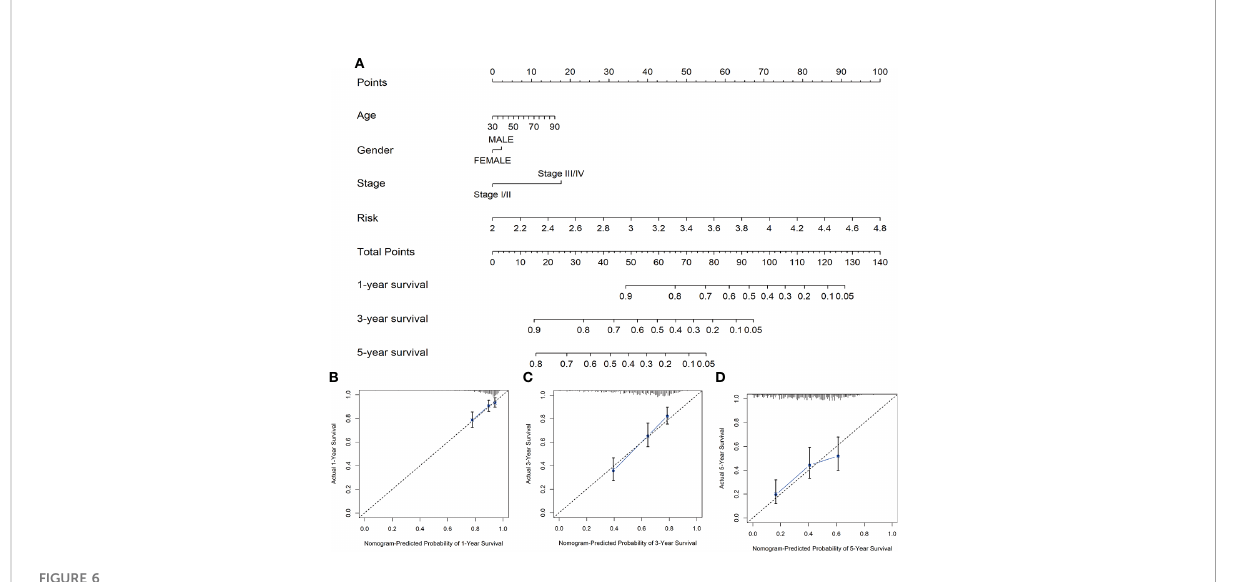
FIGURE 6 (A) Nomogram survival prediction models for predicting the OS of patients with LUAD at 1-, 3-, and 5-years. (B – D) Calibration plots of the nomogram at 1- (B) , 3- (C) , and 5- (D) year survival.